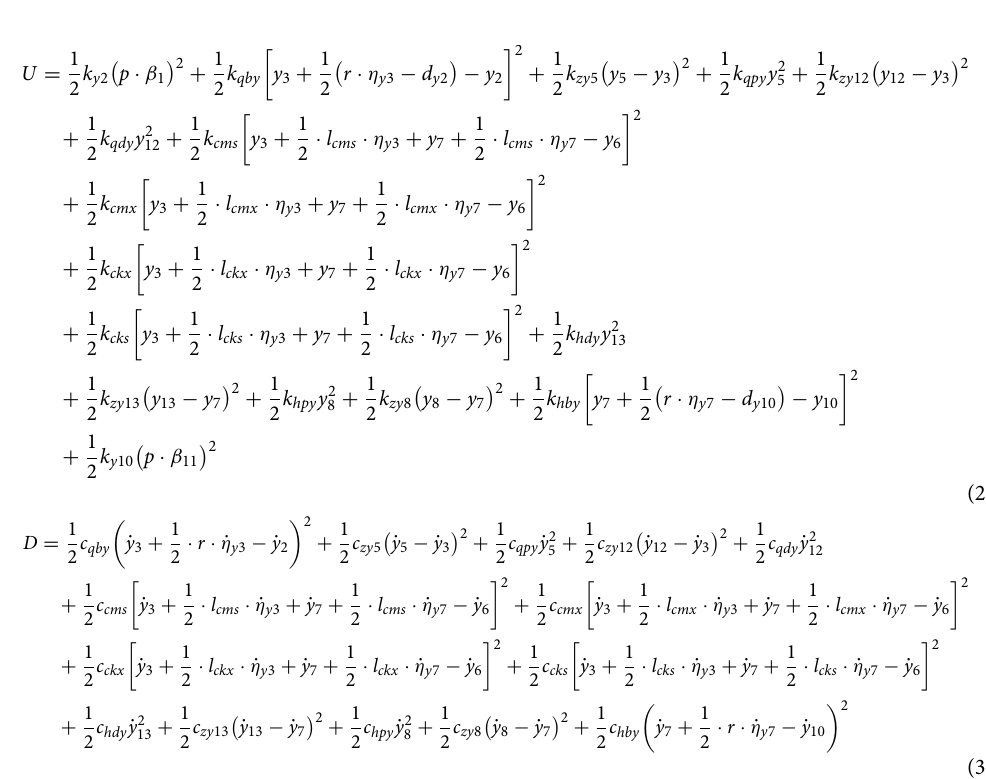
where l cms is the length of the hydraulic tie bar on the top of the mining side of the shearer, l cmx is the length of the hydraulic tie bar at the bottom of the mining side of the shearer, l cks is the length of the hydraulic tie bar on the top of the goaf side of the shearer, l ckx is the length of the hydraulic tie rod at the bottom of the goaf side of the shearer and d y2 and d y10 are the connection clearances between the front and rear rocker arms with the traction part, respectively.